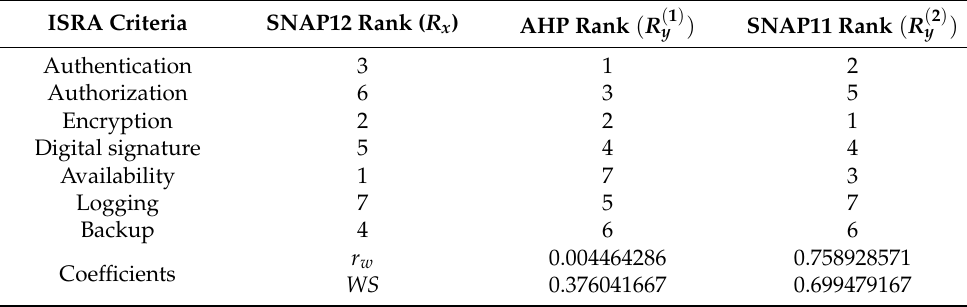
Table 8. Summary of reference rankings ( R x ) for inherent criteria for transaction systems. ISRA